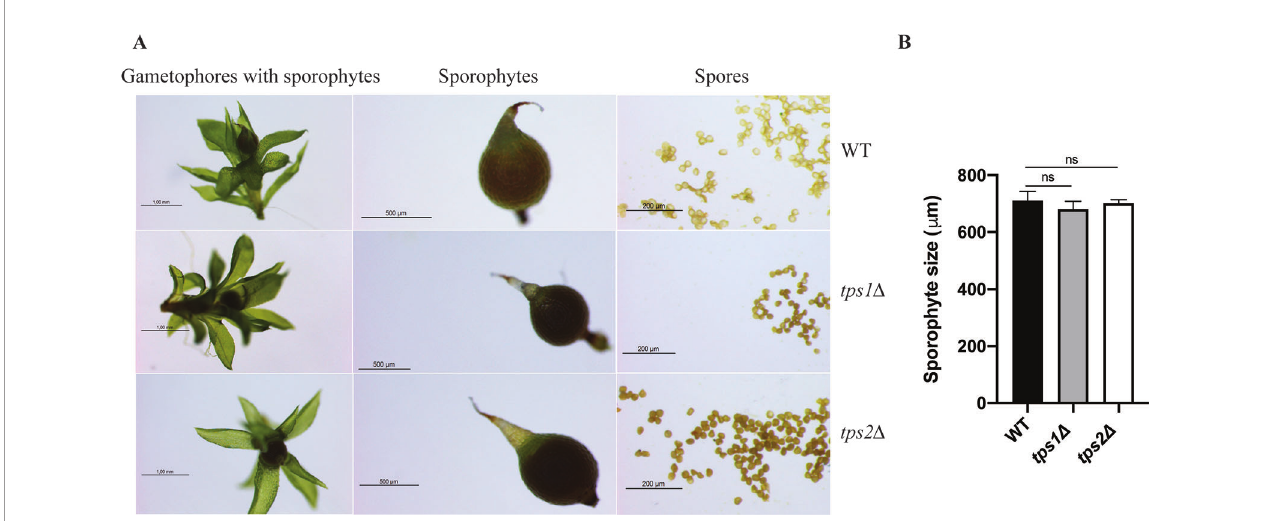
FIGURE 8 | Morphology of sporophytes of wild-type (WT), tps1 D , and tps2 D mutants (A) . Measurement of sporophyte size of WT and mutants (B) . Data represent mean ± SD of six sporophytes for each line. Statistical analysis with one-way ANOVA, ns, no signi fi cant difference.